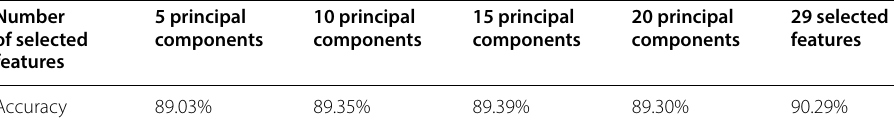
Table 5 How does the number of selected features affect the prediction accuracy Number of selected